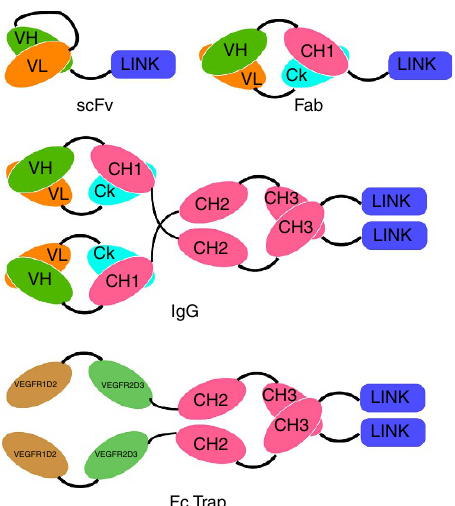
Figure 1 | Schematic of LAVAs. The HA-binding peptide (HABP) was fused to the C-terminal end of scFvs, Fabs, Fc Traps and IgGs using a single GSGGG linker. The Fc traps and IgGs have two copies of the HABP, whereas the scFv and Fab have one